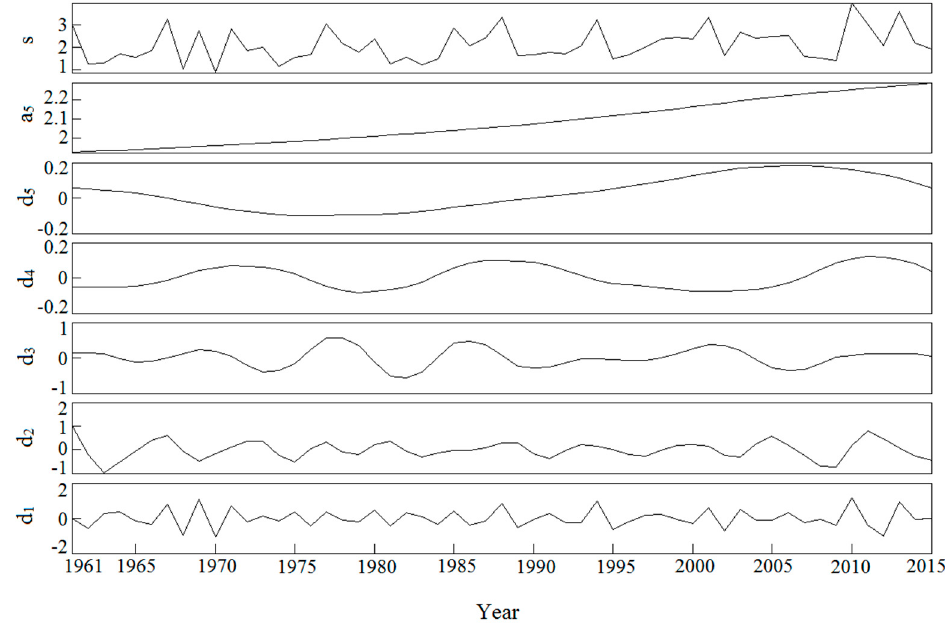
Figure 12. The decomposed Daubechies series of annual snow depth over 1961–2015 in entire Xinjiang. S represents the original signal, d 1 –d 5 are the five layers of wavelet decomposed signal, and a 5 represents the 5th layer wavelet decomposed approximation signal.